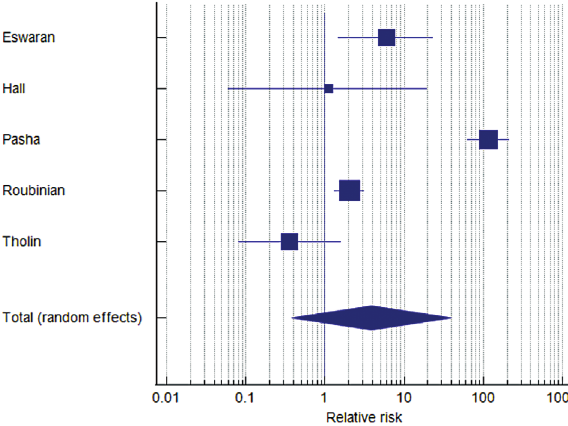
Fig. 2 Forest plot for the risk of venous thromboembolism in discharged patients compared with outpatients. Forest plot showing the pooled relative risk estimate of VTE for COVID-19 patients dis- charged from hospital compared with outpatients. The pooled rela- tive risk was 3.87 (95% CI: 0.38 – 39.18; p ¼ 0.252) with a high heterogeneity (Cochrane ’ sQ ¼ 128.34[ p < 0.001]; Higgins ’ I 2 ¼ 96.88 (95% CI: 94.82 – 98.13). CI, con fi dence interval; COVID-19, novel coronavirus disease 2019; VTE, venous arterial events occurred in 1.46% (95% CI: 1.10 – 1.86; Q-test: p ¼ 0.242, I 2 ¼ 25.57%).